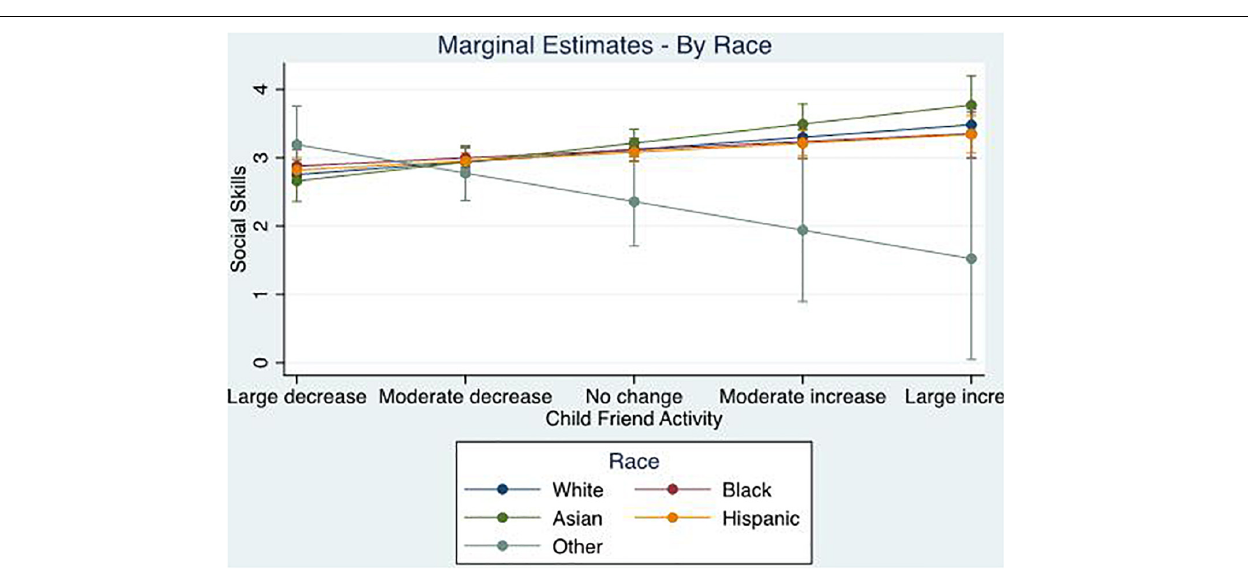
FIGURE 2 | Marginal estimates for change in social skills by race/ethnicity: change in friend